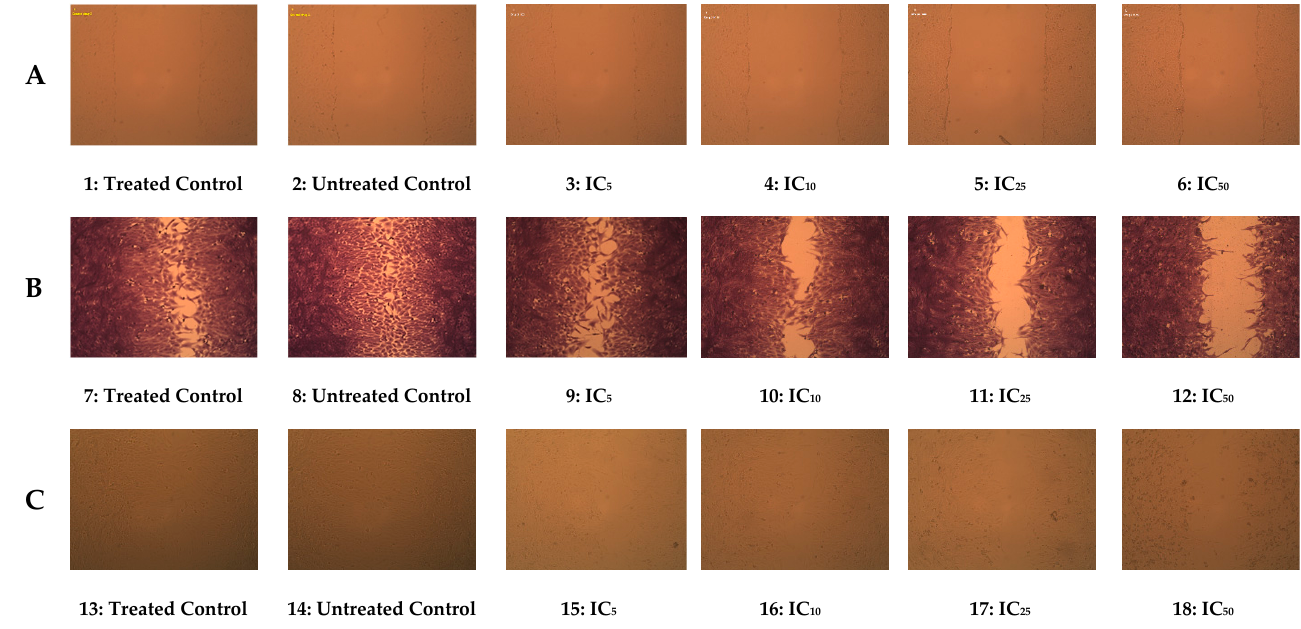
Figure 7. The impact of M. longipetala extracts on the cell cycle development of HepG2. ( A ) Micro- scopic reflection at 0 time of HepG2 cell line with 200× magnification, ( B ) Microscopic reflection after staining. ( C ) Microscopic reflection after 26 h. The photomicrographs referred to control group and treated groups at different doses of M. longipetala extracts.